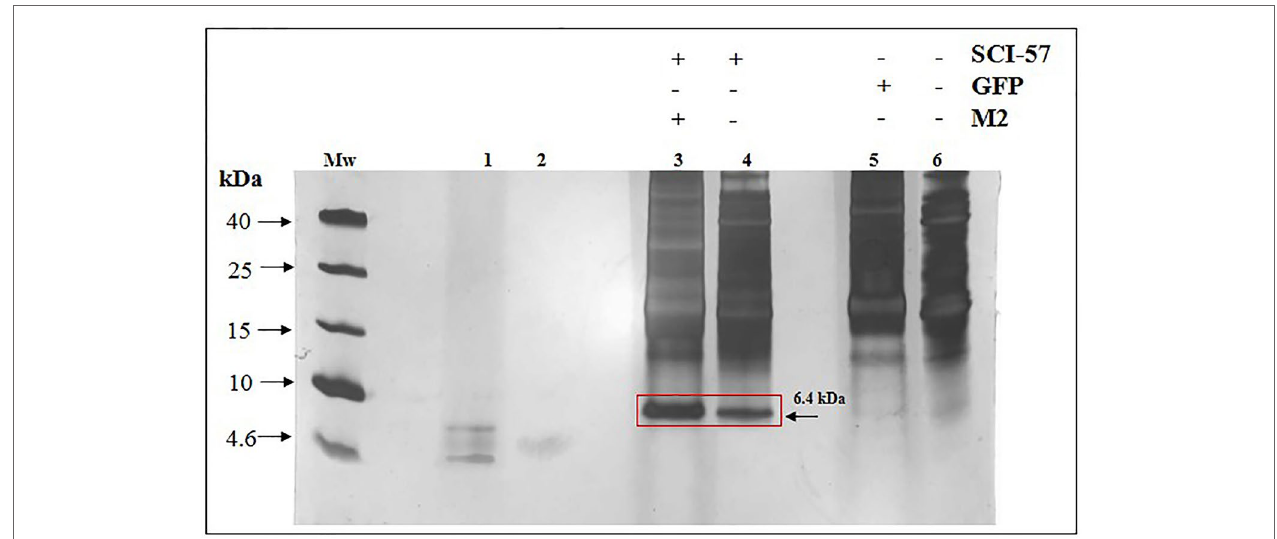
FIgUrE 2 | TSP analysis from NLEN and NLE from agroinfiltrated plants by SDS-PAGE. Twenty micrograms of TSP were loaded per lane. Mw, Molecular weight marker; lane 1, Insulin 0.01 µg; lane 2, Insulin 0.001µg; lane 3, NLE-SCI-57/M2; lane 4, NLE-SCI-57; lane 5, NLE-GFP; lane 6, NLEN. Side numbers indicate molecular mass markers in kDa. Red Square and black arrow indicates the protein corresponding to